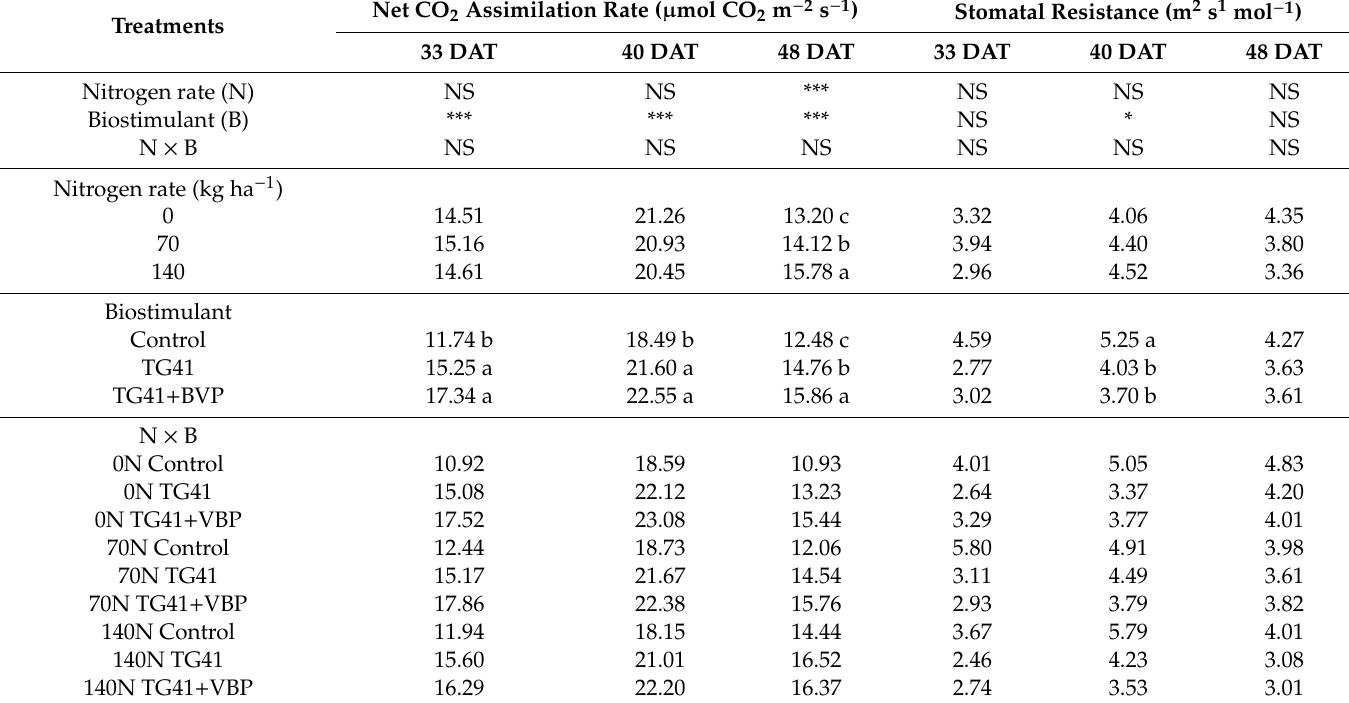
Table 2. Net CO 2 assimilation rate and stomatal resistance of greenhouse Romaine lettuce plants measured during the production cycle in relation to N